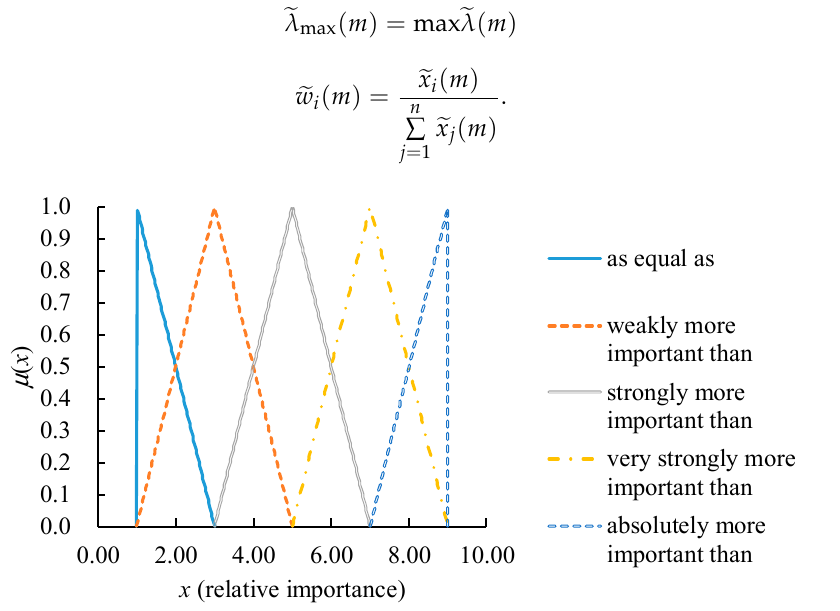
Figure 2. The triangular fuzzy numbers (TFNs) for the linguistic